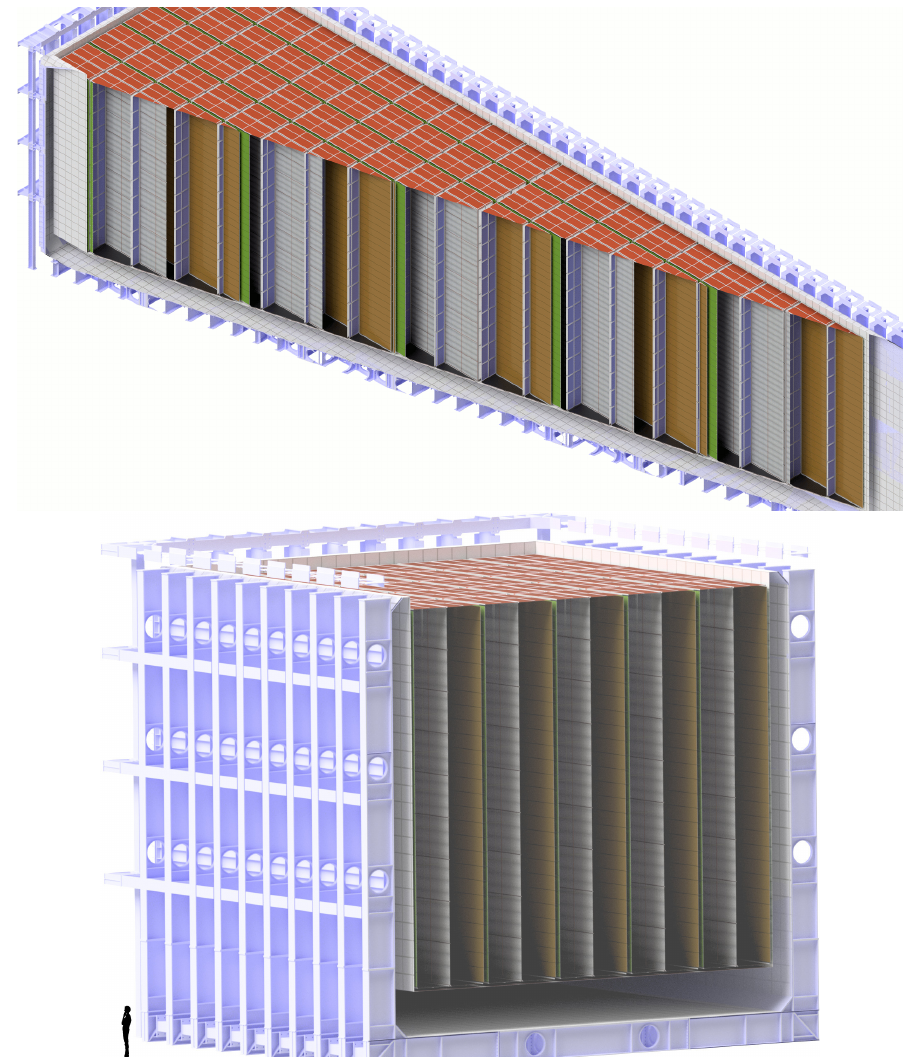
Figure 4. Potential deployment of the modular LArTPC concept discussed in this work in a Deep Underground Neutrino Experiment (DUNE) far detector cryostat. The internal cryostat dimensions are 62m long, 15.1m wide and 14m high. A figure is shown in the bottom left to give a sense of scale. There are five cathodes which divide the volume vertically into 10 separate TPCs along the drift axis (shown as white panels), with six corresponding charge-readout pixel anode planes (shown as brown panels). Optical readout planes (shown as blue panels) would enclose the face which is cut away, on both sides of the TPC. The division of the cathodes into 20 sections along the beam axis is visible along the top face of the detector in the upper image, where a diagonal slice through the detector has been made. All 200 individual TPCs are contained within a G10 structure within the